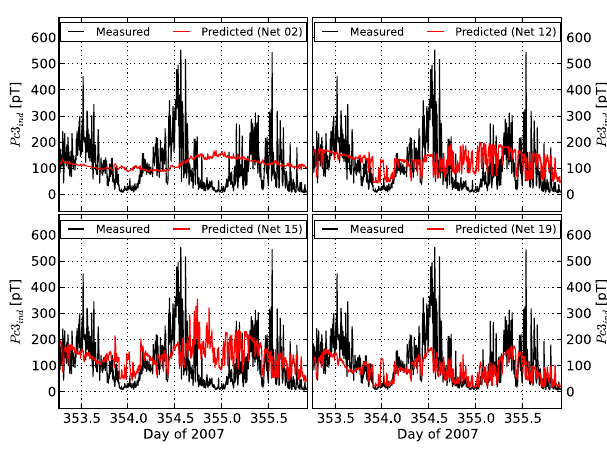
Figure 4. Measured (black) Pc3 ind and the corresponding predic- tions (in red) by networks 02 ( V sw ), 12 ( V sw , ϑ B ), 15 ( V sw , ϑ B , x x N p ) and 19 ( V sw , ϑ B , N p , χ ) for days 353–355 of 2007. These x are the fittest models in each round of training (see Table 3). Input parameters for each model are listed in